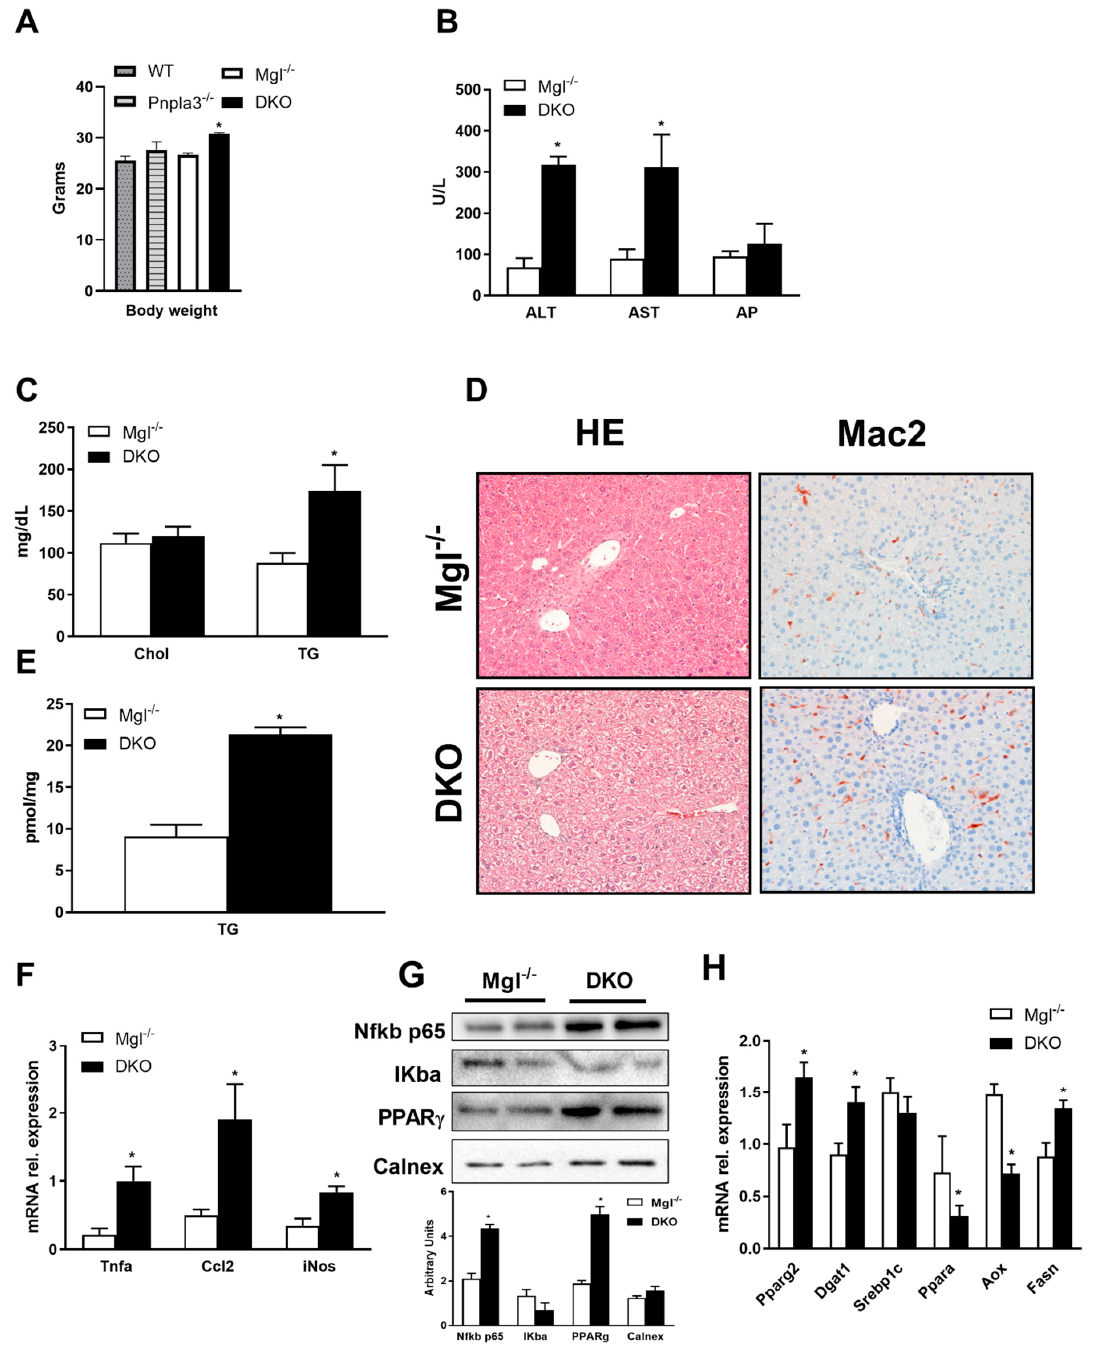
Figure 1. Absence of both monoacylglycerol lipase ( Mgl ) and patatin-like phospholipase domain containing protein-3 ( Pnpla3 ) increase susceptibility to weight gain and hepatic inflammation. ( A ) Body weight measurement revealed increased weight gain in double knockout ( DKO ) compared to other genotypes on a chow diet. ( B ) Serum biochemistry reflects increased levels of transaminases (ALT, AST—but unchanged AP) as well as ( C ) increased TG levels and unchanged cholesterol in DKO on a high-fat diet (HFD). ( D ) Representative hematoxylin and eosin (H&E) images (10 × magnification) with markedly increased steatosis and inflammation (Mac-2) in DKO versus Mgl − / − . ( E ) Increased liver TGs in DKO on a HFD. ( F ) Hepatic gene expression of proinflammatory markers Tnf α , Ccl2 , and iNos increased together with ( G ) protein expressions and respective quantifications of NFKb p65 and PPARg whilst IKba were decreased. ( H ) Hepatic gene expressions of Pparg2, Dgat1, and Fasn increased, whereas beta-oxidation decreased as demonstrated by Ppara and Aox genes. Results are expressed as mean ± S.D.; * p < 0.05 for Mgl − / − versus DKO